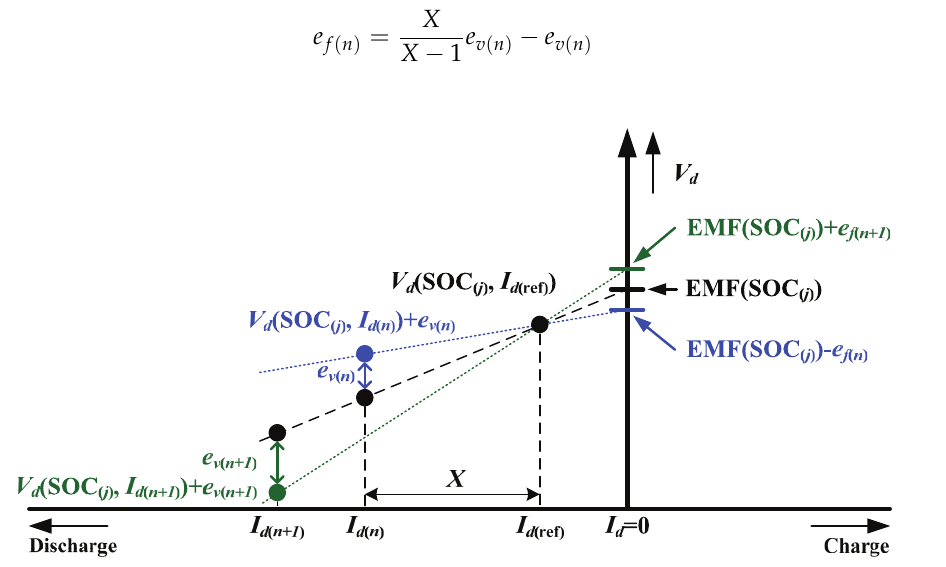
Figure 5. The I d ( ref ) should be close enough to the zero current, so the impacts of voltage errors on EMF values can be